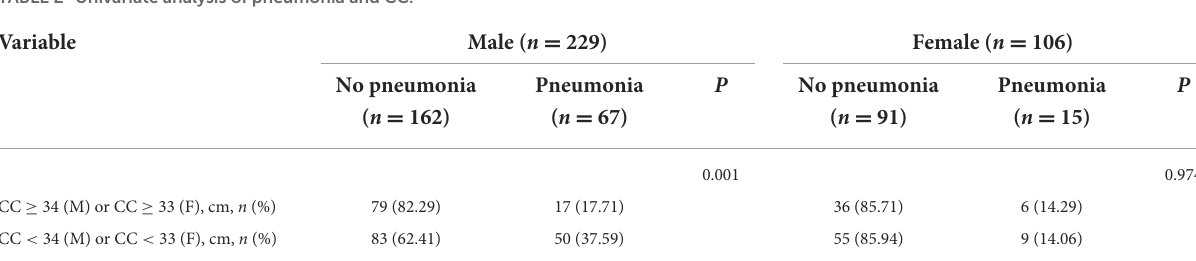
TABLE 2 Univariate analysis of pneumonia and CC.